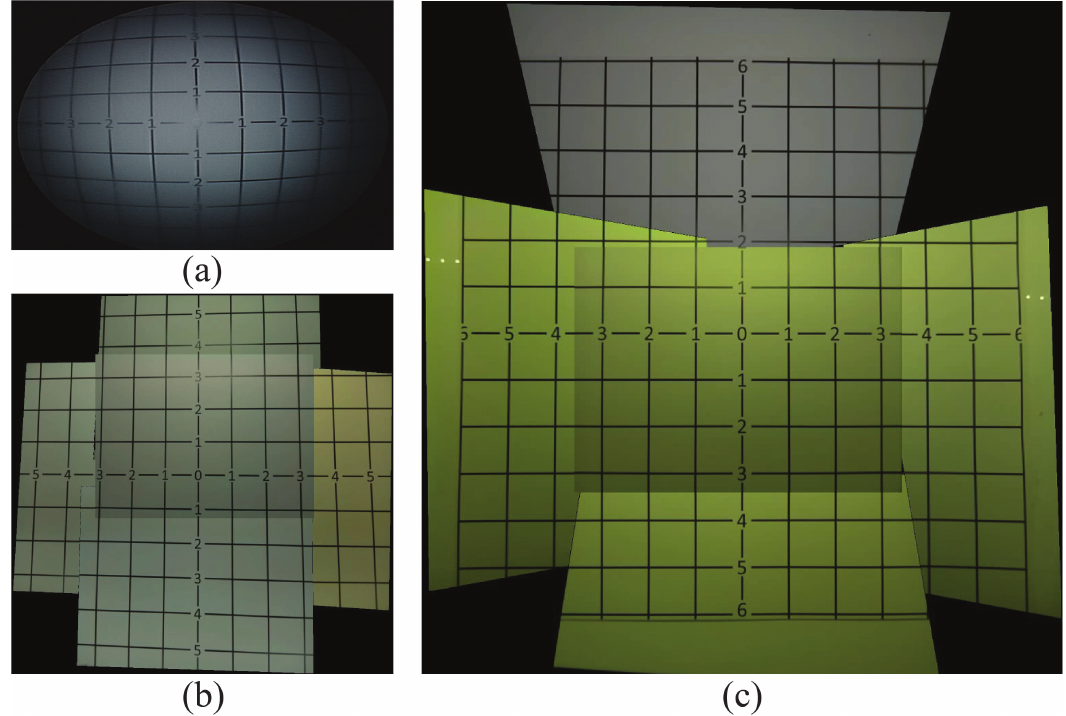
Figure 4. FoV Measurement: Captured images from ( a ) a traditional laparoscope, ( b ) a non-tilted camera array, and ( c ) the micro-camera array with tilted cameras for FoV measurement using grid lines. The micro-camera array can provide larger FoV and detect larger area (133 visible squares) compared with the traditional laparoscope (56) or non-tilted array